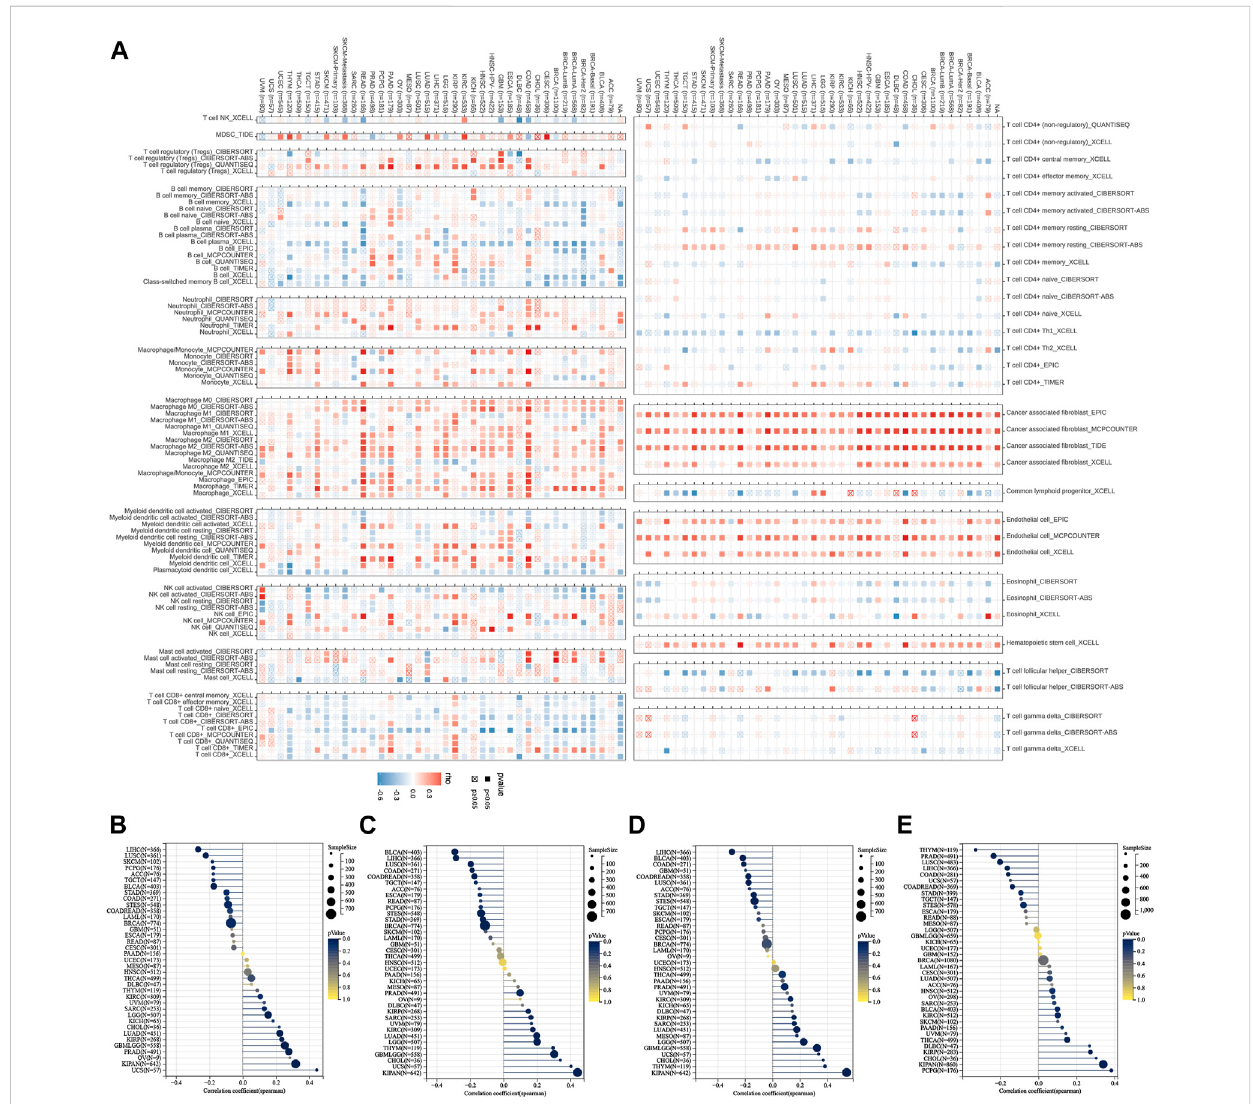
FIGURE 8 The correlations of P4HA3 expression and the in fi ltration levels of CD4 + T cells, cancer-associated fi broblast, macrophages, and many other immunecellsincancers (A) .Positivecorrelationinredandnegativecorrelationinblue.TheRelationshipof P4HA3 expressionwithtumorstemnessindex from (B) DMPss (C) DNAss, (D) ENHss, and (E) EREG-METHss